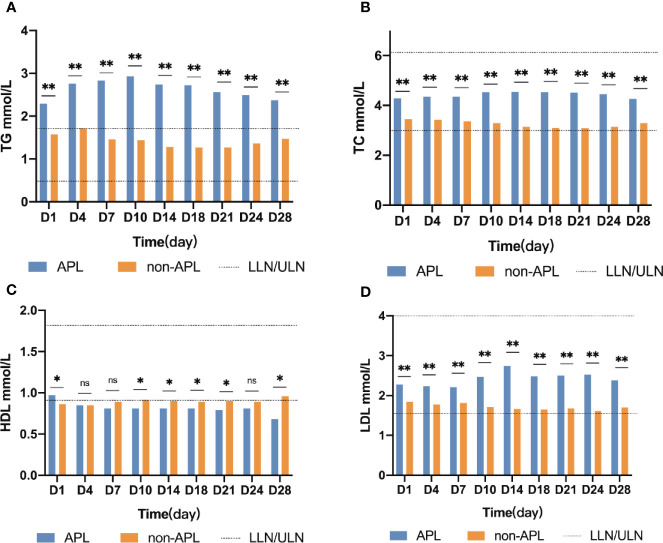
Lipid kinetics. Significant difference (*P < 0.05,**P < 0.0001); n.s., not significant. APL, acute promyelocytic leukemia; non-APL, acute myeloid leukemia exclude of APL; TG, triglyceride; TC, cholesterol; HDL, high-density lipoprotein cholesterol; LDH, low-density lipoprotein cholesterol; ULN, upper limits of normal; LLN, lower limits of normal.